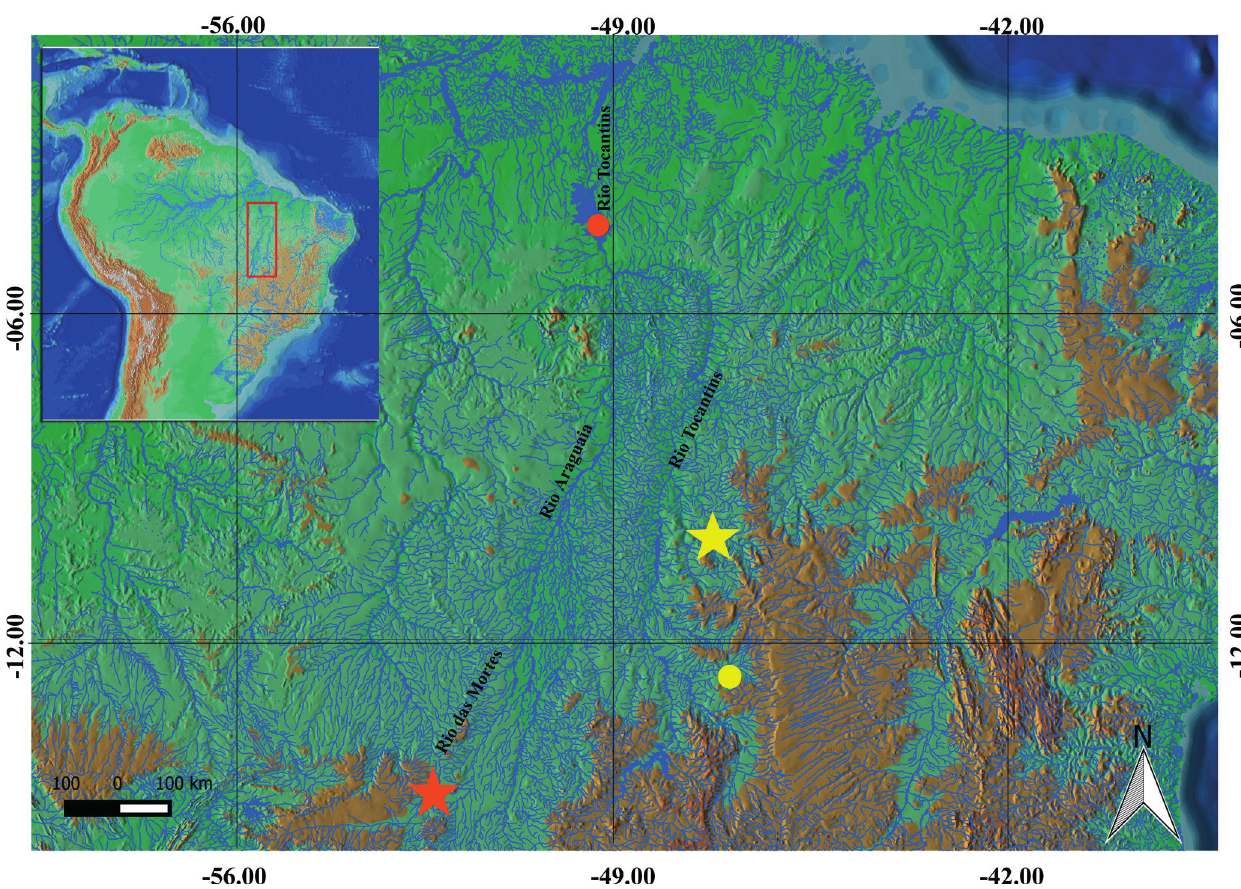
FIGURE 6 | Distribution of Tatia akroa (yellow) and T. simplex (orange). Stars represent type localities.